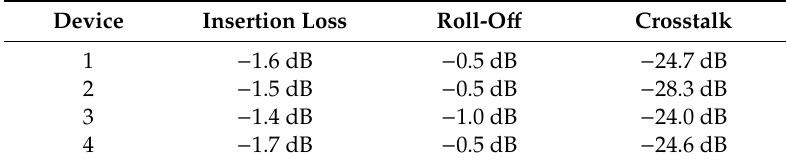
Table 1. Performance of the echelle demultiplexer measured on four di ff erent device copies fabricated in the same